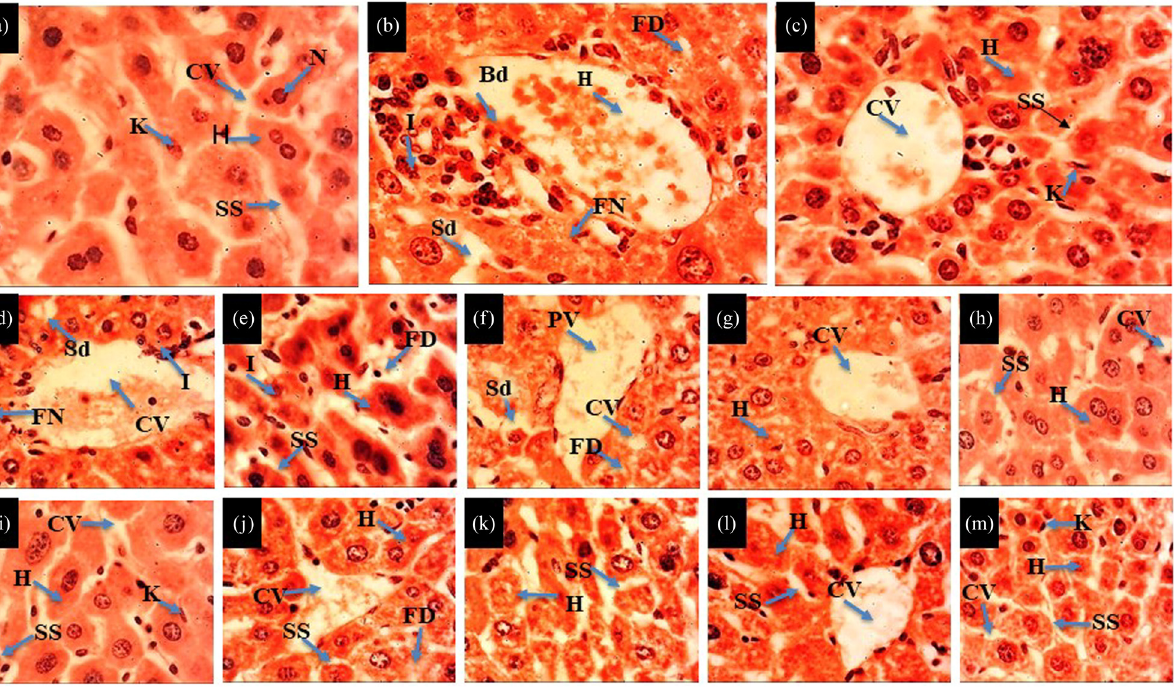
Figure 1: Photomicrograph of liver section of mice. Group I: normal control ( NC ) mice ( a ) , Group II: 25% CCl 4 toxicant control ( b ) and